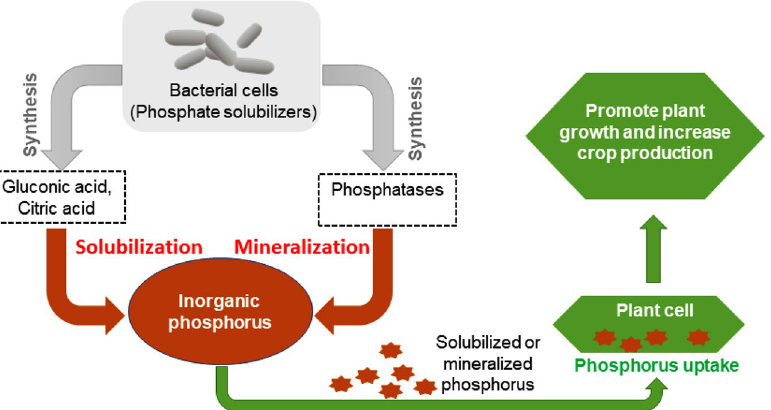
Figure 4. Inorganic phosphorus solubilization by phosphate-solubilizing rhizobacteria. A bacterium solubilizes inorganic phosphorus through the action of low molecular weight organic acids such as gluconic and citric acids. The hydroxyl (OH) and carboxyl (COOH) groups of these acids chelate the cations bound to phosphate and thus convert insoluble phosphorus into a soluble organic form. The mineralization of soluble phosphorus occurs by synthesizing different phosphatases which catalyze the hydrolysis process. When plants incorporate these solubilized and mineralized phosphorus molecules, eventually, overall plant growth and crop yield significantly